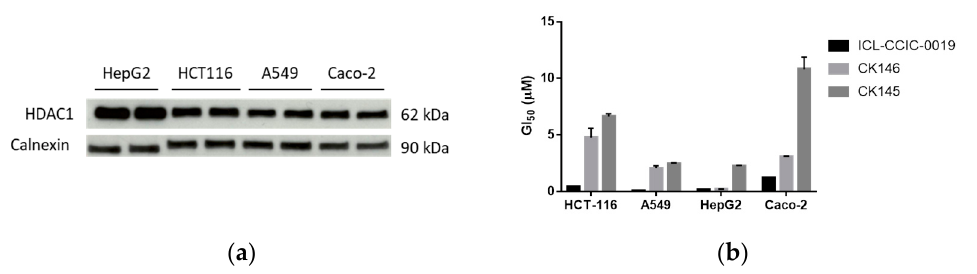
Figure 3. Antiproliferative activity characterization of ICL-CCIC-0019, CK146 and CK145. ( a ) Im- munoblotting analysis of HDAC1 in HepG2, HCT-116, A549 and Caco-2 cell lines ( n = 2); ( b ) Com- parison of growth inhibitory activity among ICL-CCIC-0019, CK146 and CK145 in HCT-116, A549, HepG2 and Caco-2 cells ( n = 6, mean ± SD).